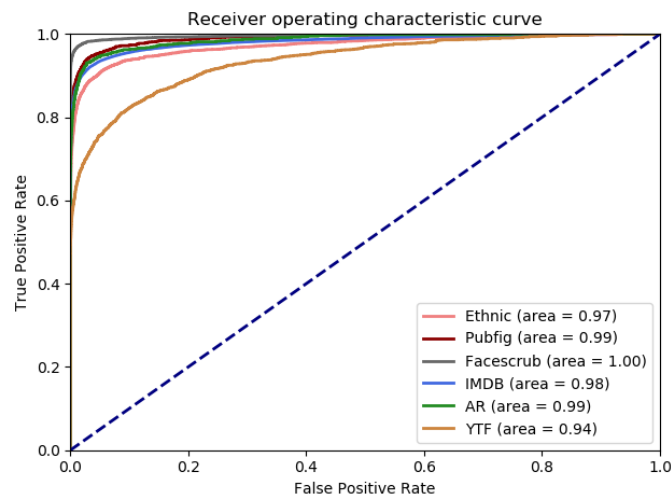
with and ( b ) varying 𝑚𝑚 𝑞𝑞 = 32